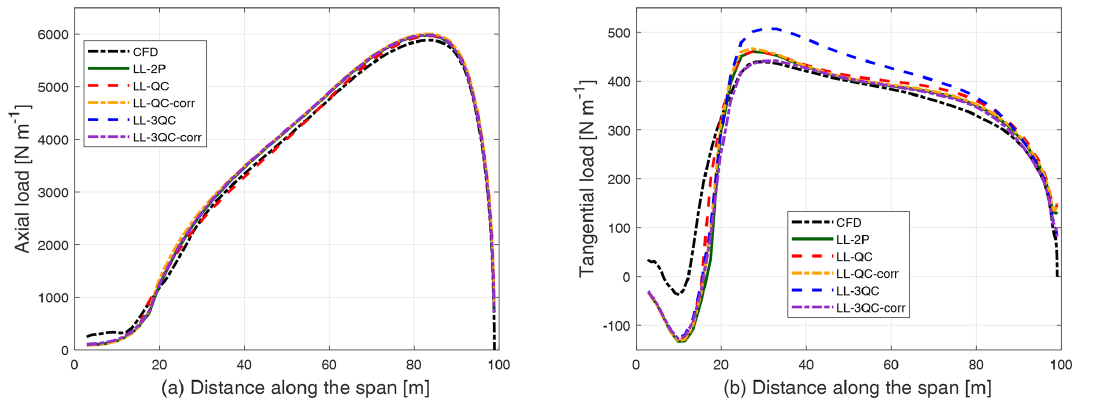
Figure 12. Comparison of axial load (a) and tangential load (b) of the straight blade with 15 ◦ of downwind coning calculated from different implementations of the LL method and the fully resolved CFD.